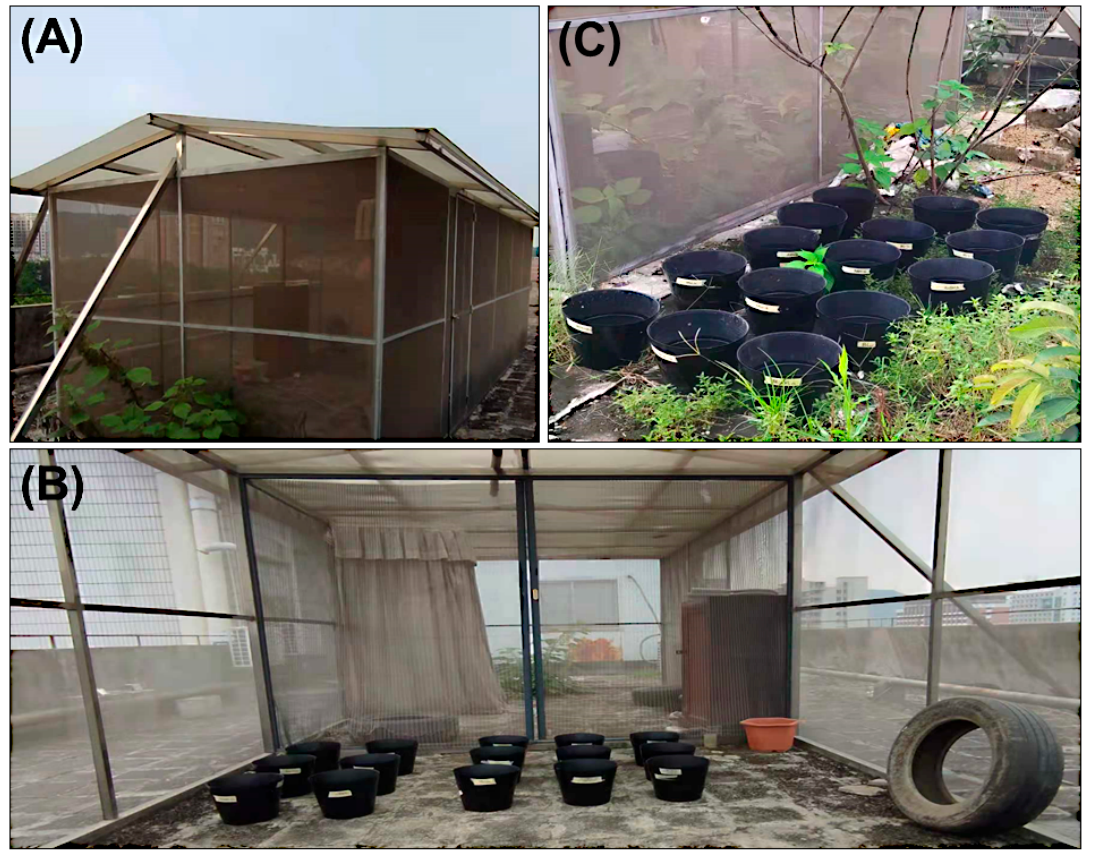
Figure 1. Bioassay environment. ( A ) Semi ‐ field system (SFS). ( B ) Experimental semi ‐ field bioassay treatment. ( C ) Experimental open ‐ field bioassay treatment.